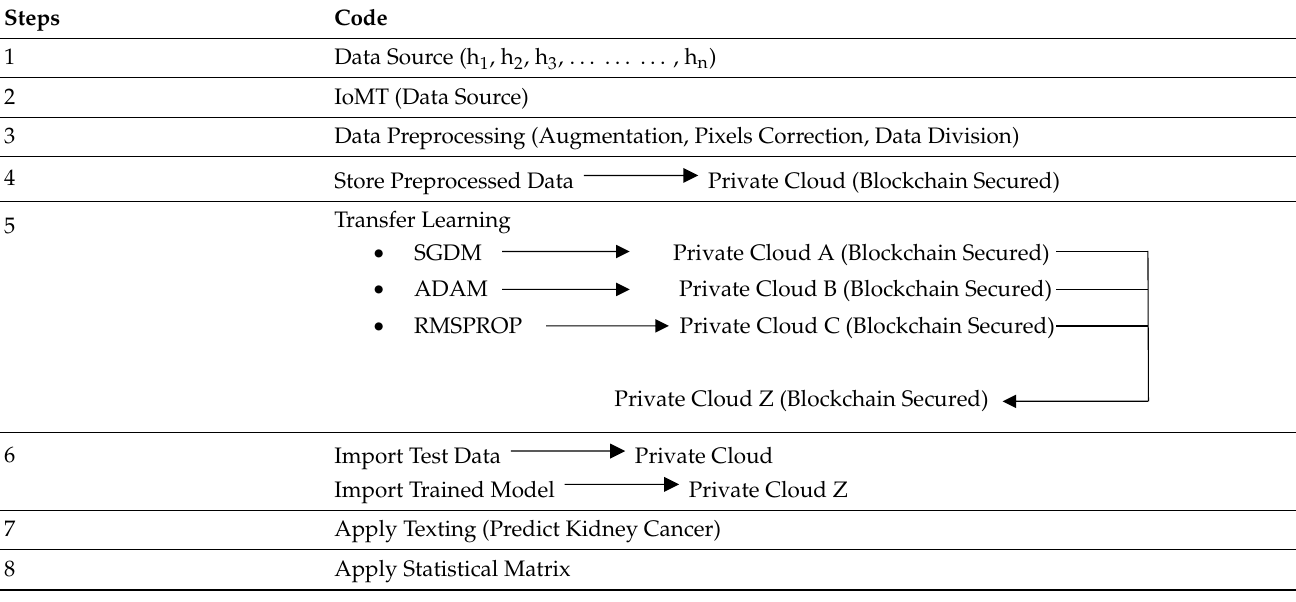
Table 2. Pseudocode IoMT-based proposed framework for the prediction of kidney cancer.